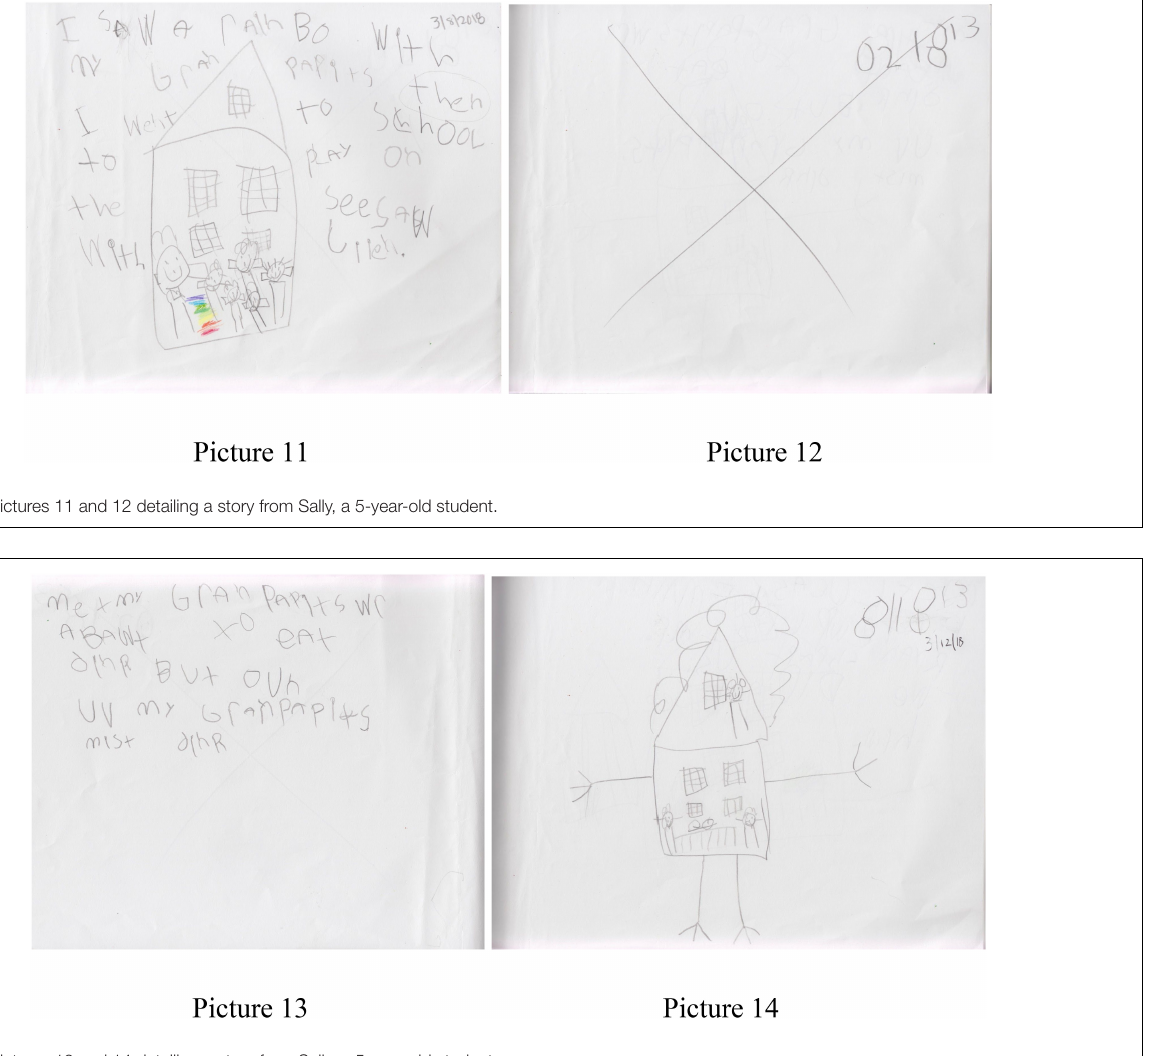
FIGURE 6 | Pictures 13 and 14 detailing a story from Sally, a 5-year-old